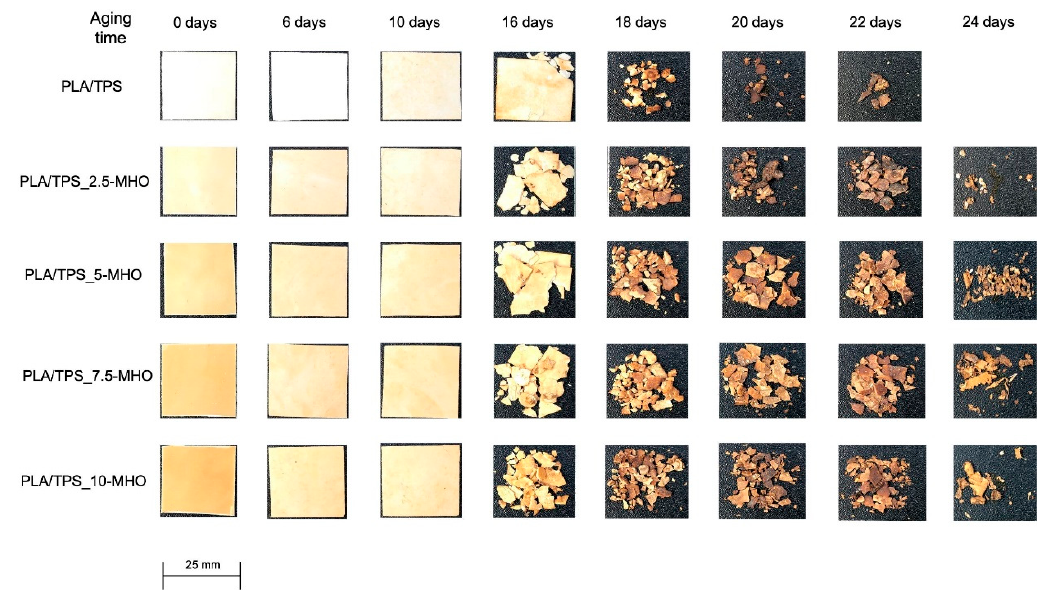
Figure 7. Visual appearance of disintegration in controlled compost soil of PLA/TPS blend unplasticized and plasticized with different amounts of MHO content.